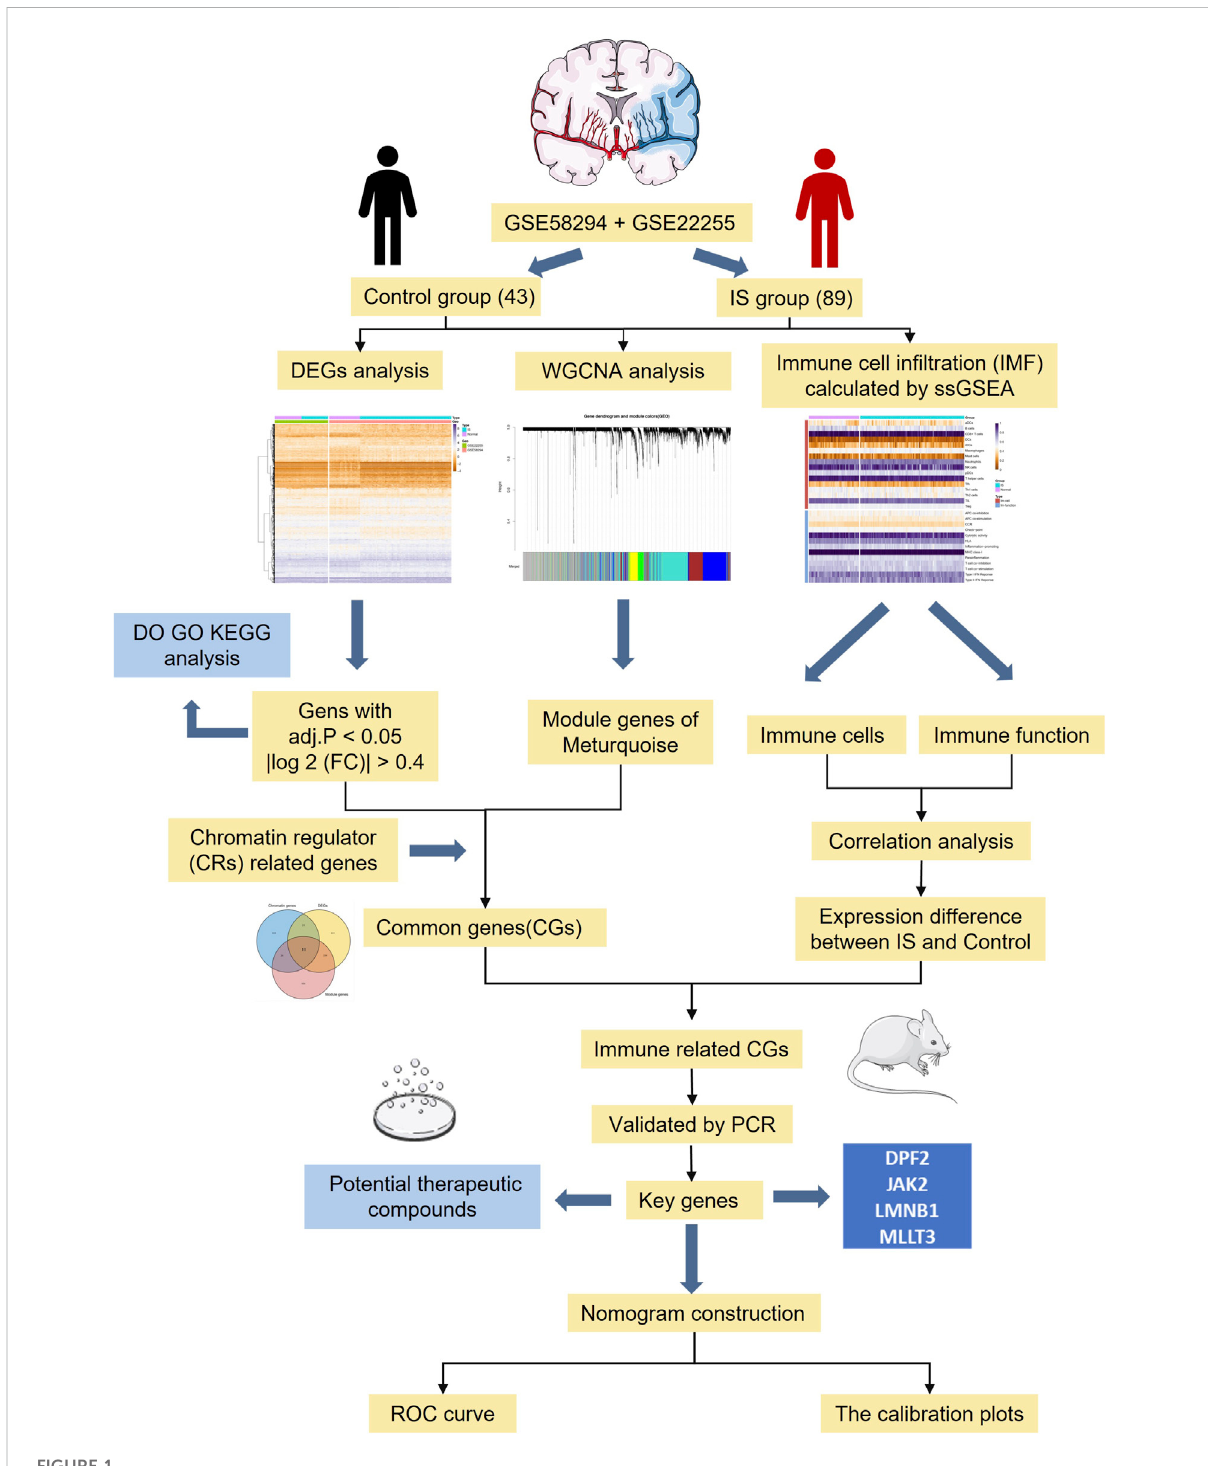
FIGURE 1 The fl owchart of data preparation and